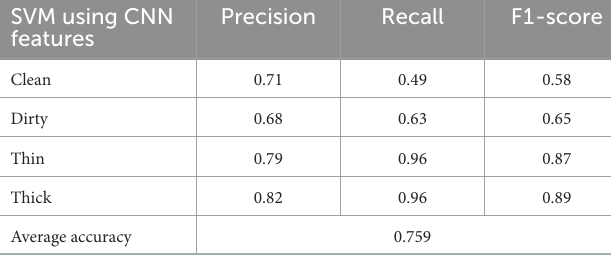
TABLE 2 Results of SVM using CNN feature